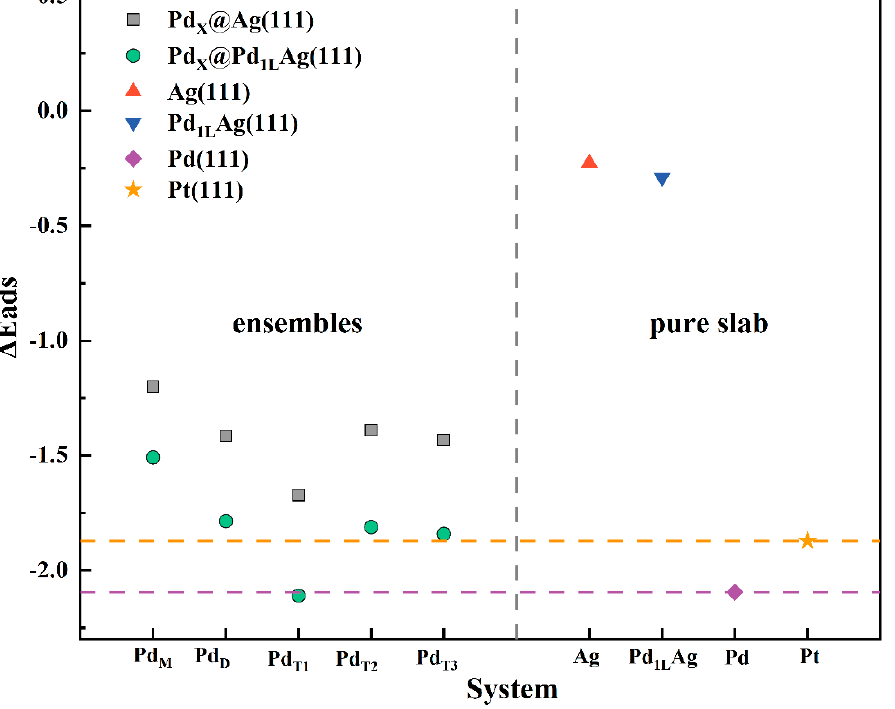
Figure 6. Adsorption energies of CO on different adsorption sites of the modified surfaces and pure slabs. The yellow dashed line is the adsorption energy of CO on pure Pt(111). The purple dashed line is the adsorption energy of CO on pure Pd(111).